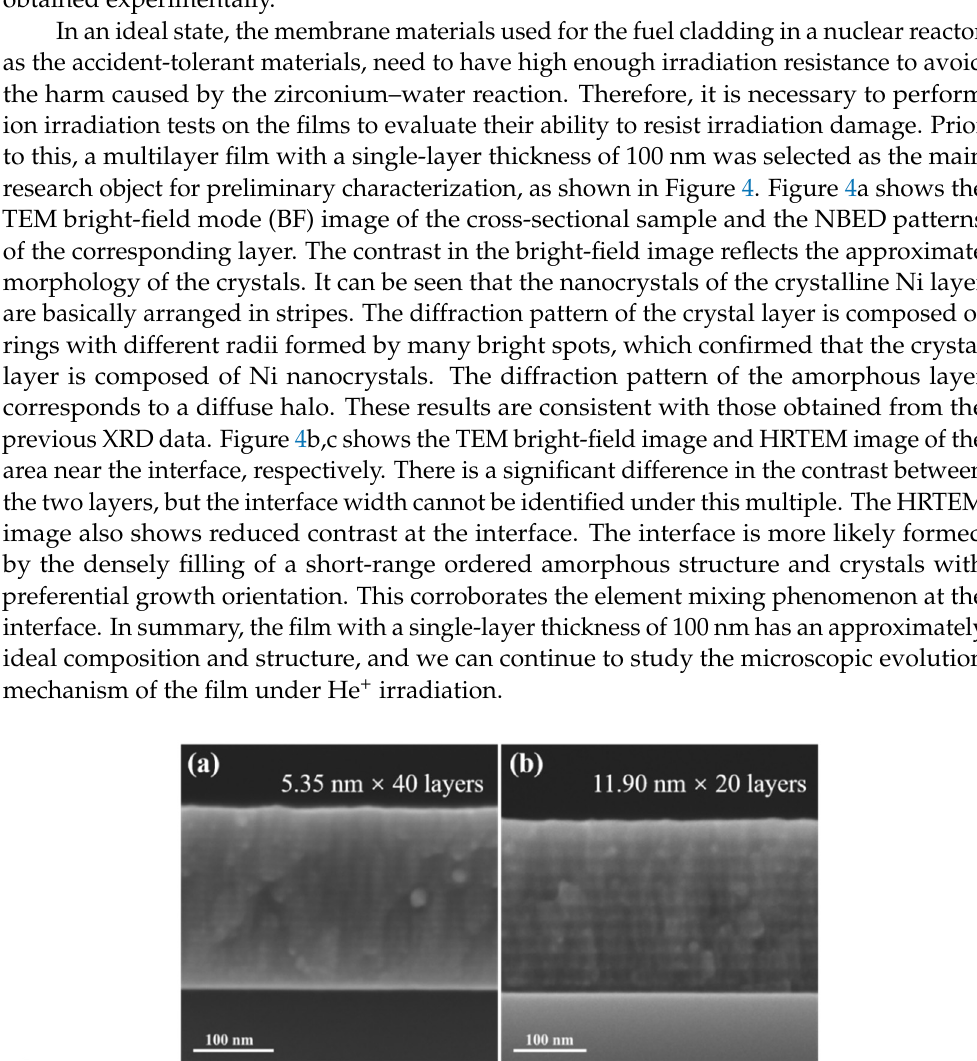
Table 2. Real average layer thickness (T r ) and grain size in different orientations (D (hkl) , D = D (111) ) of amorphous ZrC/nanocrystalline Ni multilayers.